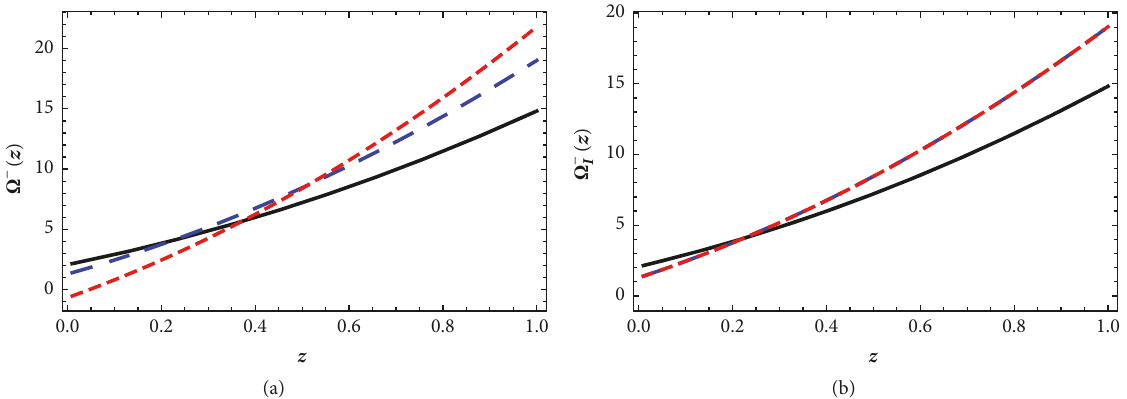
Figure 4: Evolution of fraction dark energy as function of red-shift 𝑧 for Ω 𝐷 = 0.70 and 𝐻 0 = 73𝑘𝑚𝑠 −1 𝑀𝑝𝑐 −1 , (a) noninteracting and (b) interacting cases.